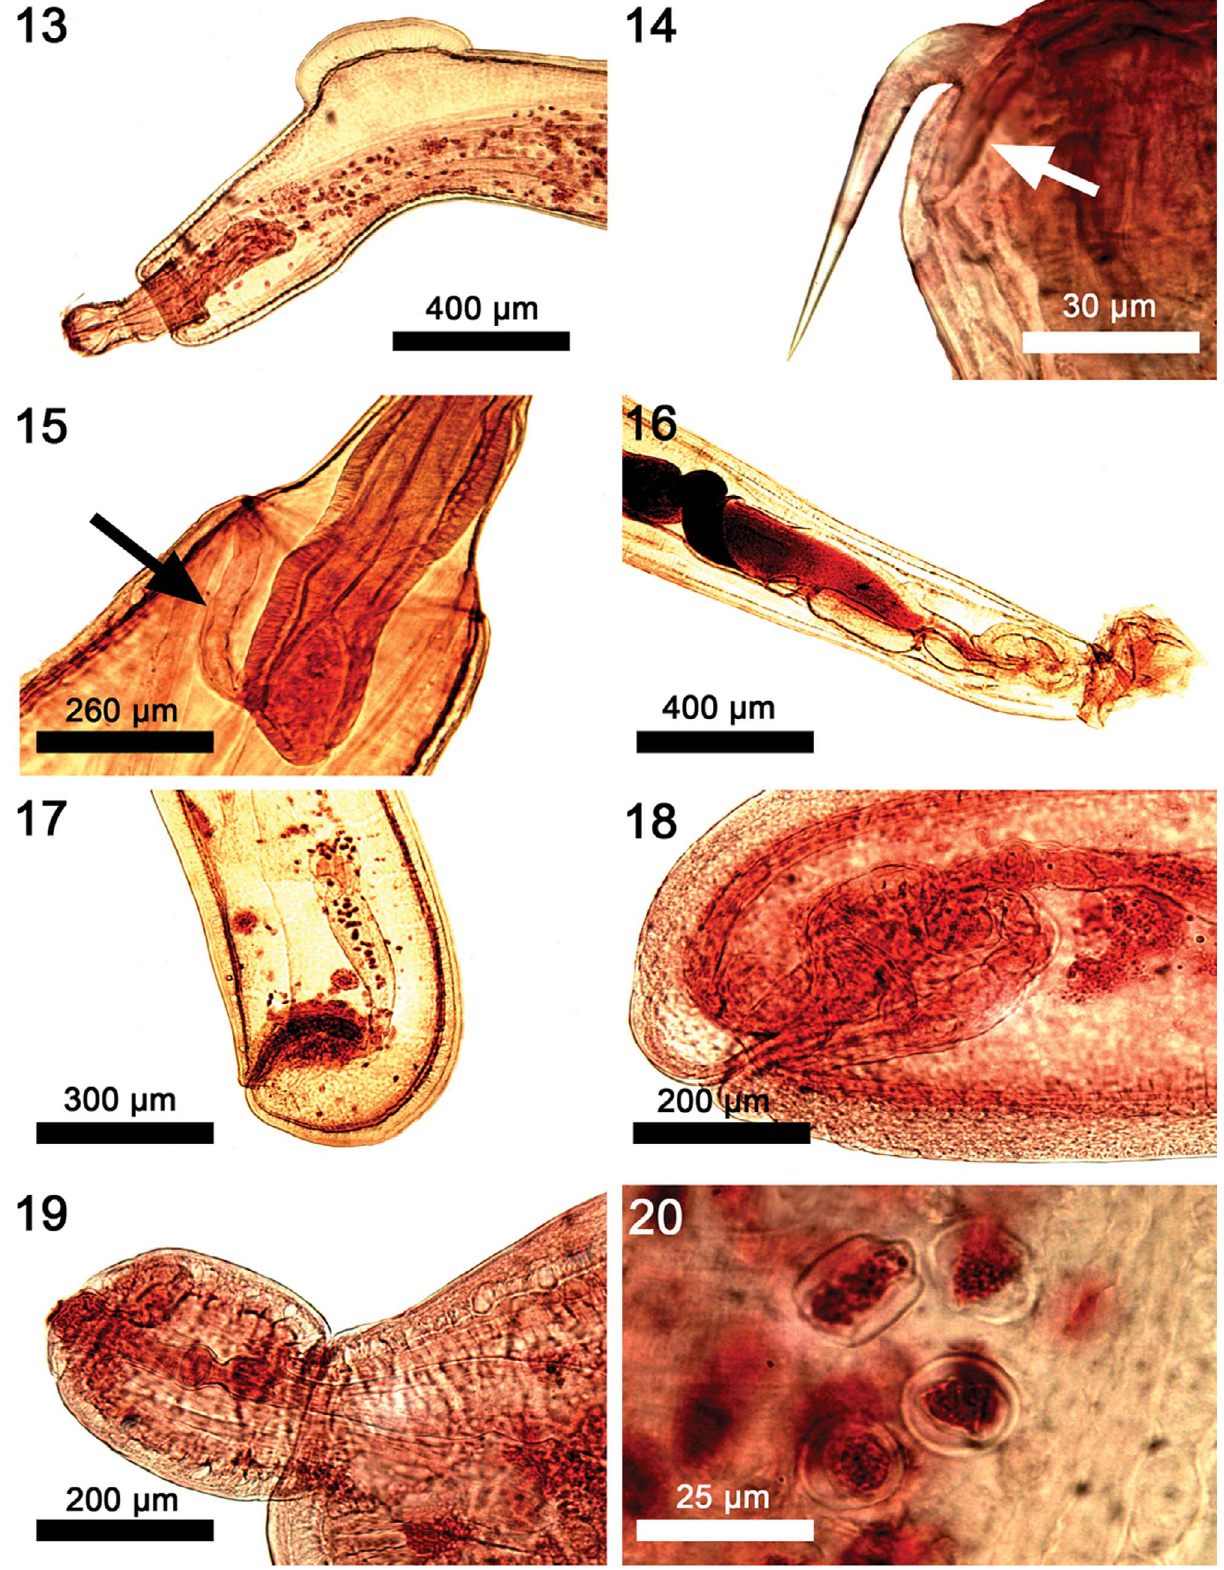
Figures 13 – 20. Microscopic images of specimens of Neoechinorhynchus johnii from Eleutheronema tetradactylus, Johnius carouna, and Otolithes ruber in the Paci fi c Ocean off Vietnam. (13) The anterior end of a male specimen showing the typical dorsal curvature and humping. (14) The anterior proboscis showing its characteristic curvature at the base and the prominent posteriorly directed root (arrow). (15) An anterior trunk section showing the para-receptacle structure (arrow) penetrating into the posterior receptacle wall near the large cephalic ganglion. (16) The male reproductive system of a young specimen. (17) The posterior end of a female reproductive system with a typical expanded curved vagina and a subventral gonopore. (18) Another typically convoluted posterior end of a female reproductive system. (19) An image showing an often-observed constriction at the posterior tip of a female trunk. (20) A rare image of the two types of eggs in the same frame, the spheroid egg and the lantern-like